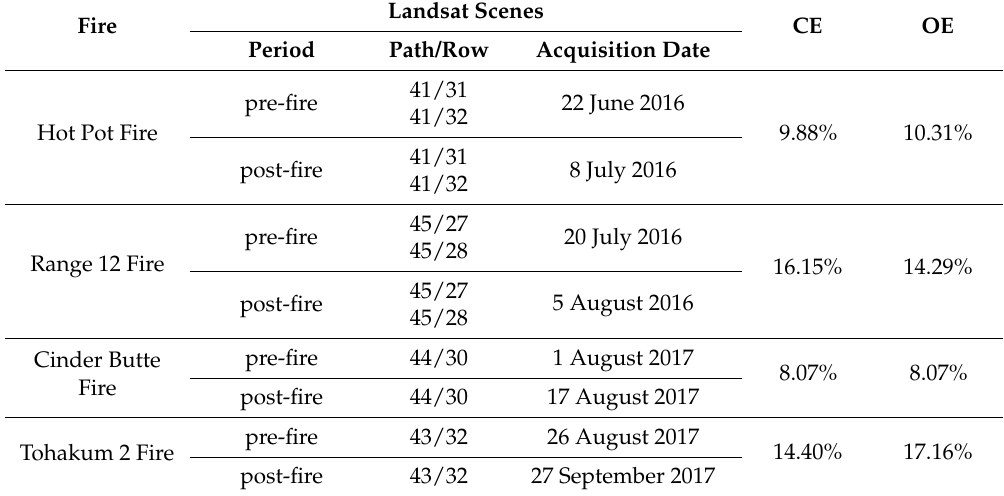
Table 7. Information of the used Landsat-8 OLI scenes and the CE and OE of the new method in the four wildfire